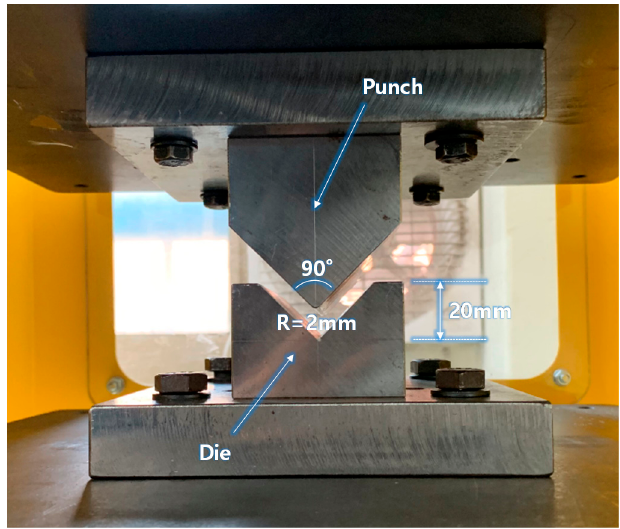
Figure 4. Experimental setting of the V-bending.